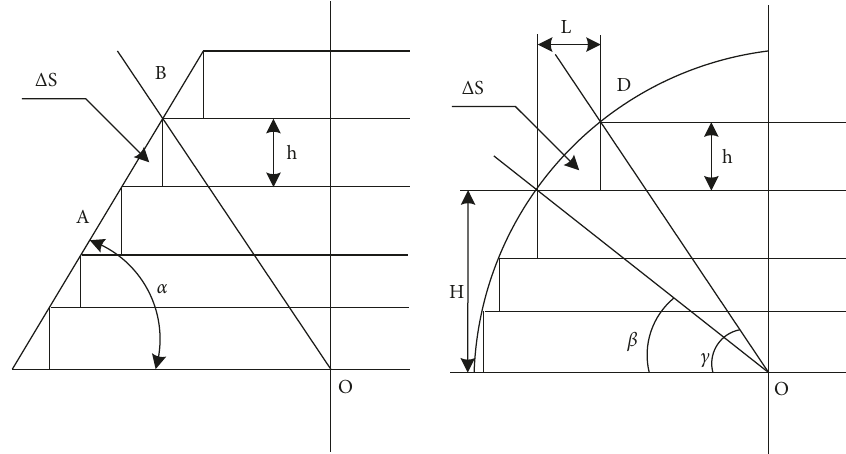
Figure 5: Schematic diagram of composite